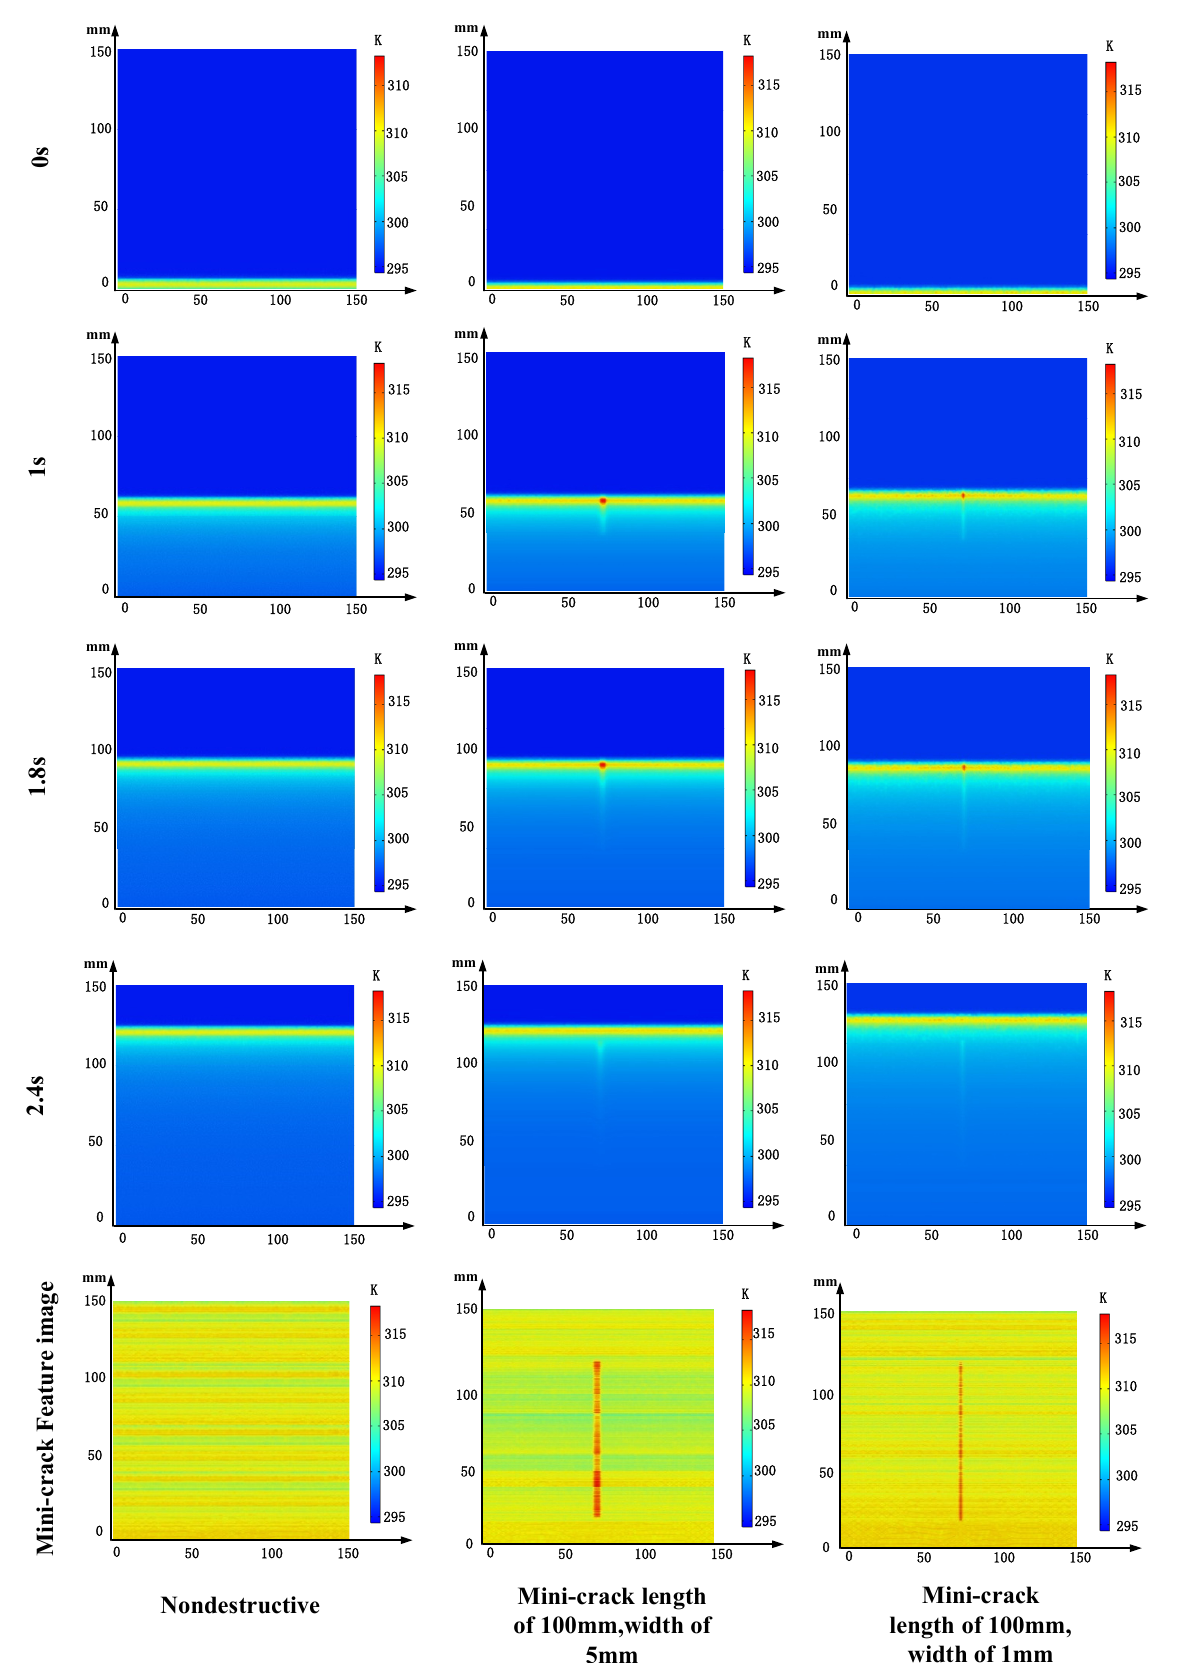
Figure 10. Surface temperature thermographs of three surface conditions of the conveyor belt.